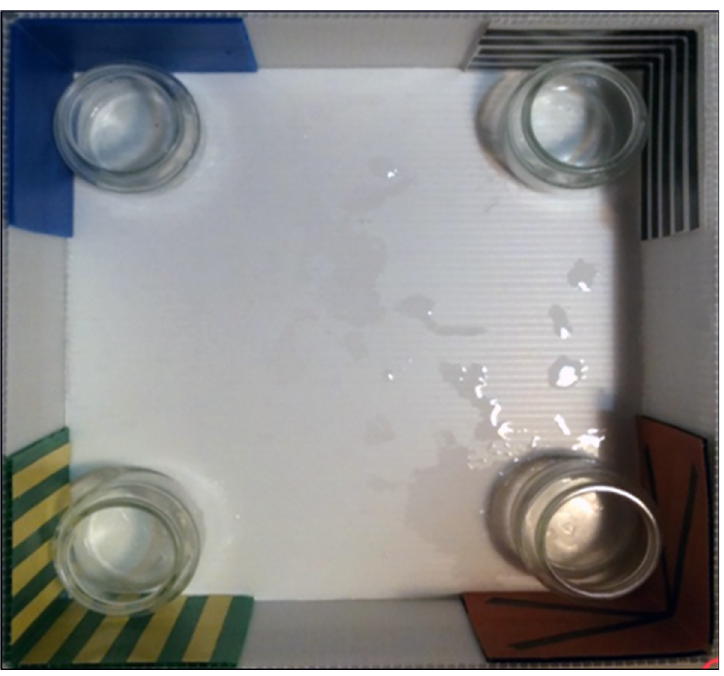
Fig 2. Square experimental arena for the spontaneous memory task. Photograph of square tank used in Experiment 2 with different colored panels at corners, using a spontaneous memory procedure involving a social cue.